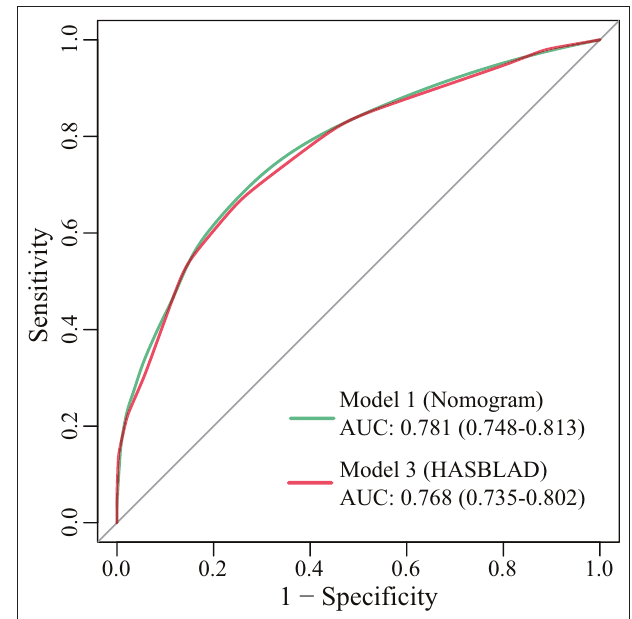
FIGURE 4 | ROC curves for Model 1, Model 3 in the training set. AUC, area under the curve; ROC, receiver operating